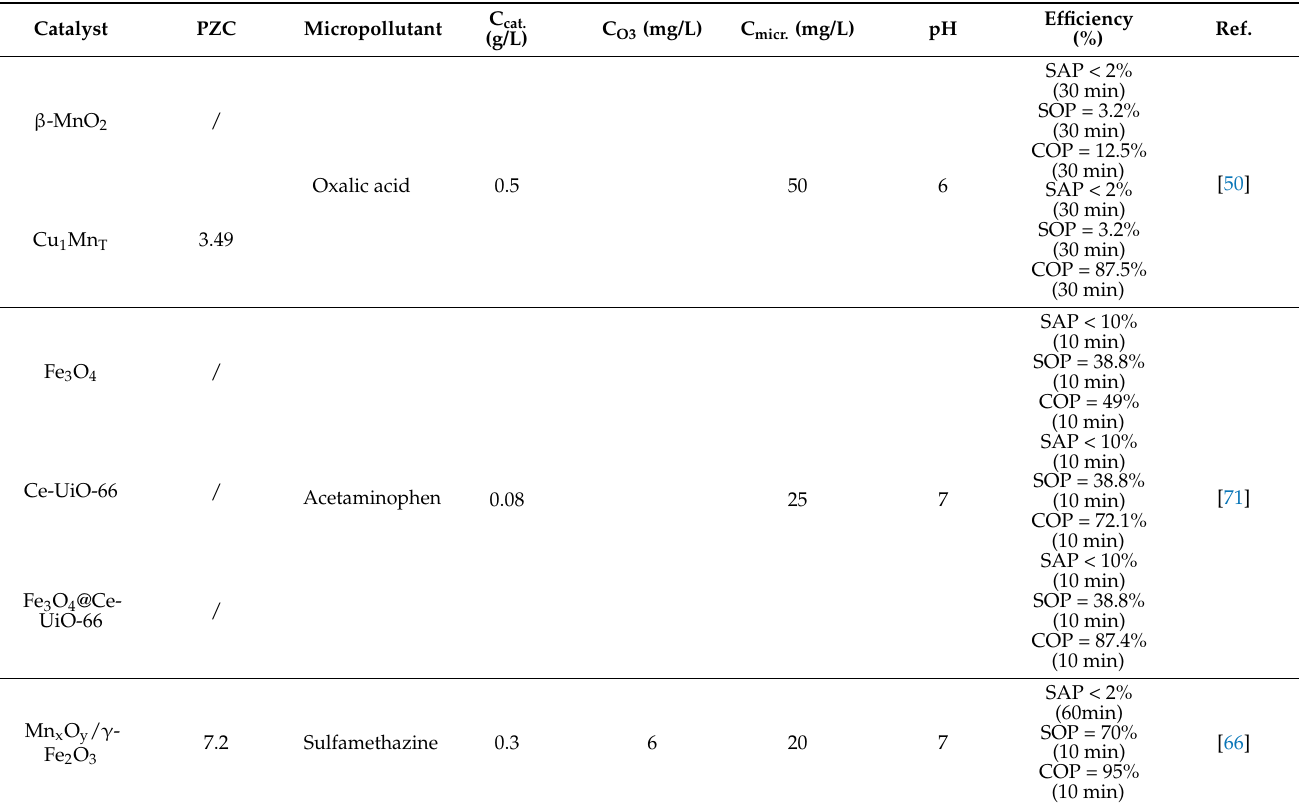
Table 2. Metals deposited onto substrates and the composite materials used as catalysts during the heterogeneous catalytic ozonation process (at the pH range